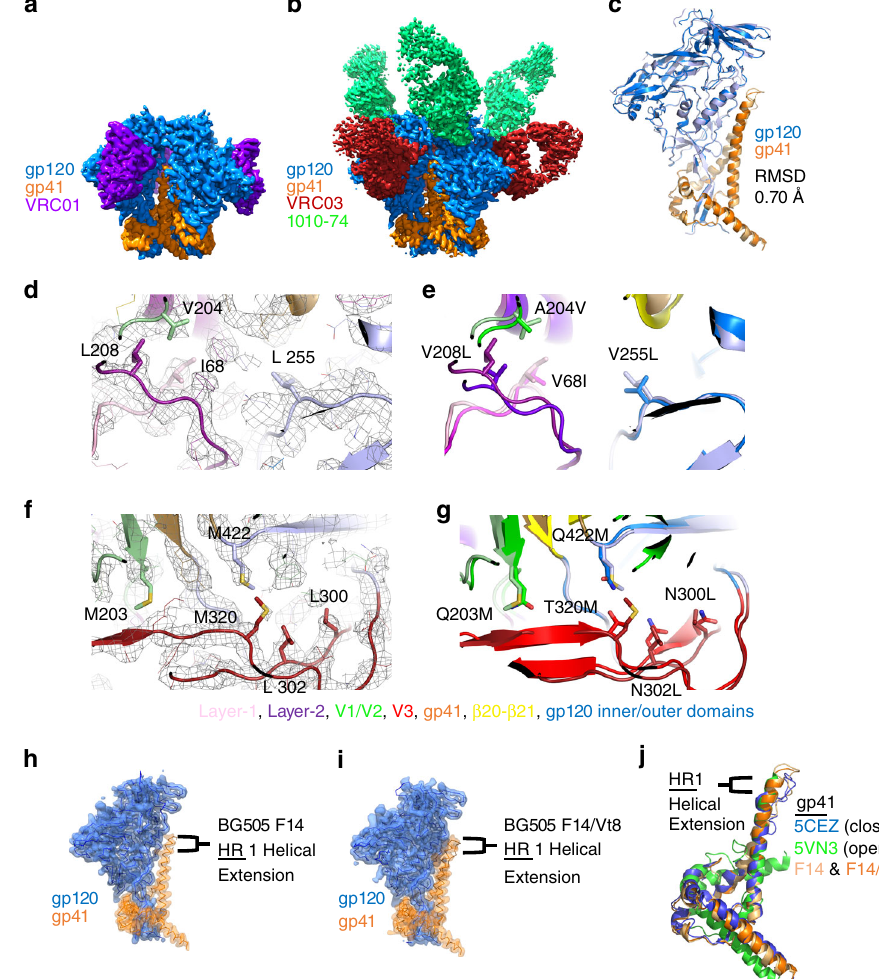
Fig. 3 Structural details of BG505 F14 SOSIP and BG505 F14/Vt8 SOSIP. a Re fi ned cryo-EM map of BG505 F14 SOSIP (gp120 in blue and gp41 in orange) bound to VRC01 (purple). b Re fi ned cryo-EM map of BG505 F14/Vt8 SOSIP (gp120 in blue and gp41 in orange) bound to VRC03 (red) and 10- 1074 (green). c Alignment of BG505 F14 SOSIP gp140 and BG505 F14/Vt8 SOSIP gp140. RMSD is for the alignment of gp120 and gp41 together. d Cryo- EM map of the BG505 F14/Vt8 construct with fi tted coordinates depicting the F14 mutation sites. e Alignment of the BG505 F14/Vt8 SOSIP gp120 with the BG505 SOSIP gp120 showing the relative positions of the F14 mutations. f Cryo-EM map of the BG505 F14/Vt8 construct with fi tted coordinates depicting the Vt8 mutations. g Alignment of the BG505 F14/Vt8 SOSIP gp120 with the BG505 SOSIP gp120 showing the relative positions of the Vt8 mutation sites. h , i Transparent cryo-EM maps with ribbon representations of re fi ned coordinates for BG505 F14 and F14/Vt8 SOSIPs (gp120 in blue and gp41 in orange) identifying gp41 HR1 helical extension. j Alignment of gp41 three-helix bundle helix (residues 571-596) of BG505 F14 and F14/Vt8 SOSIPs (light orange and orange, respectively), an open state BG505 SOSIP (PDB ID 5VN3; green), and a closed state BG505 SOSIP (PDB ID 5CEZ; blue) identifying the extension of the gp41